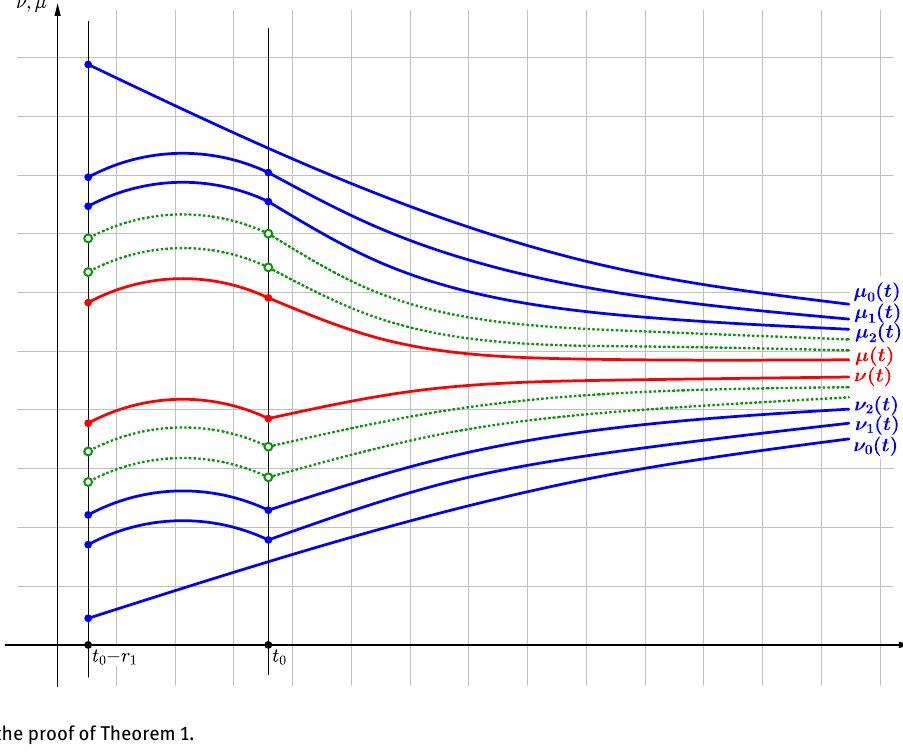
Fig. 1: To the proof of Theorem